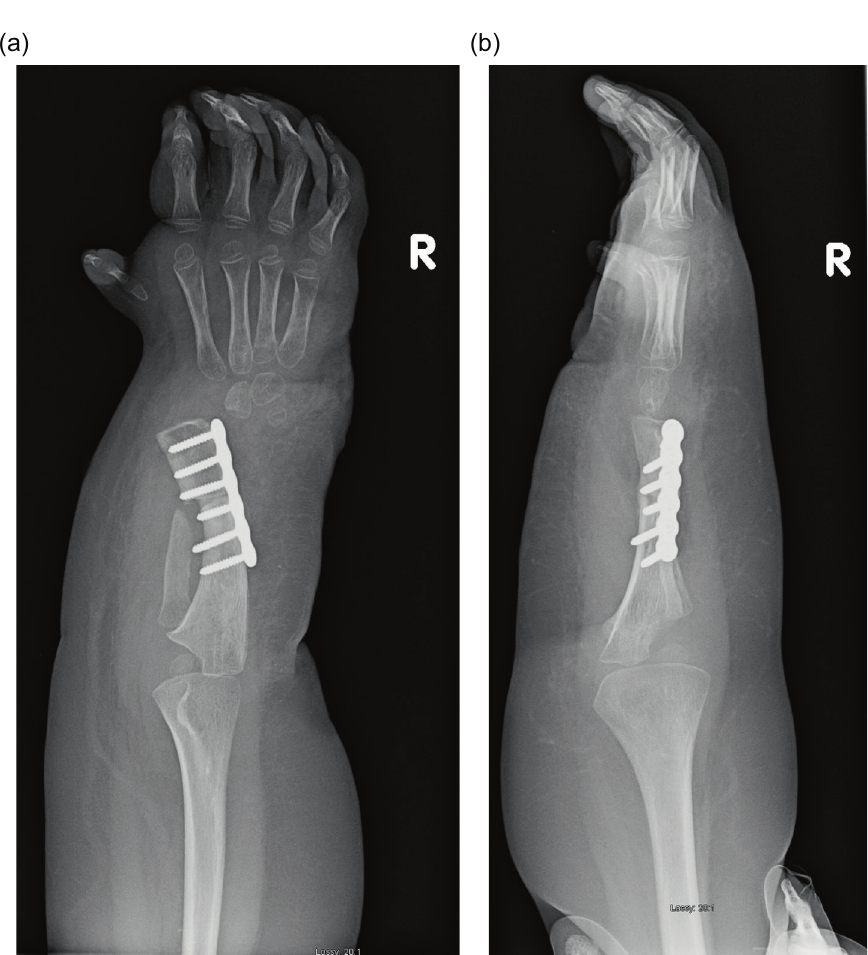
Figure 28. AP and lateral radiographs after removal of the wires. Note that the ulnar head remains at station.